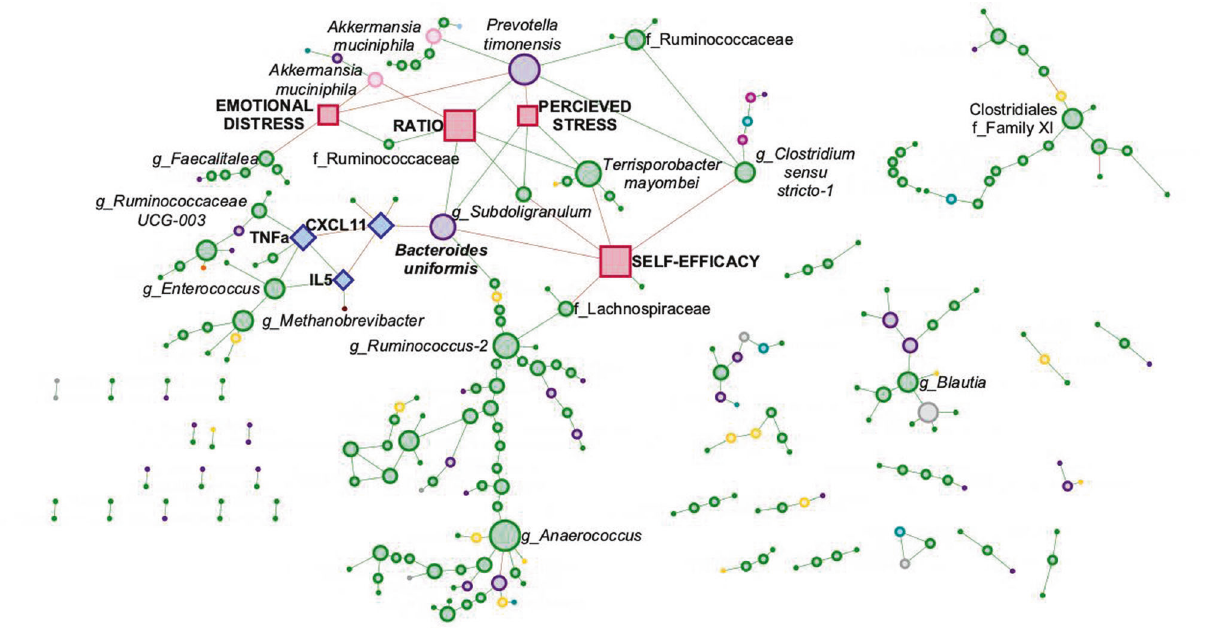
Fig. 5 Bacteroides uniformis mediates the associations between the immune system, through CCXL11, and the self-reported rPS assessments, through rSE and the ratio between rED and rSE. Associations between cytokines and chemokines with correlation coef fi cients were >0.65 and q < 0.001 were included in the fi gure. Associations with rPS, rED, rSE and rRatio were considered signi fi cance with a q < 0.05. Associations between ASV were calculated with SparCc. Node size is associated with its number of neighbors. ASVs, circles; cytokines, diamonds; stress scores, squares. Firmicutes, green; Bacteroidetes, purple; Actinobacteria, yellow; unidenti fi ed bacteria, gray; Verrucomicrobia, light pink; Protobacteria, blue; Euryarchaeota, brown; Epsilonbactereota, orange; Tenericutes, light blue; Fusobacteria, fuchsia. Green edges, positive correlations; red, negative